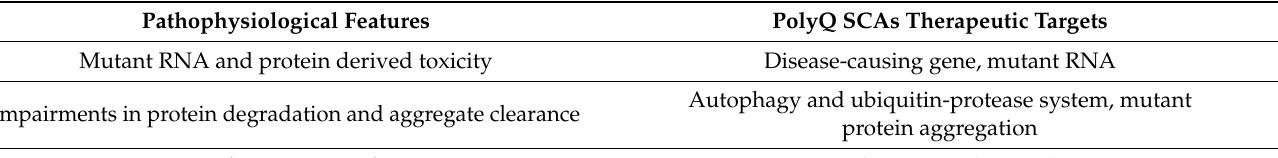
Table 2. PolyQ SCAs pathophysiological features and proposed therapeutic